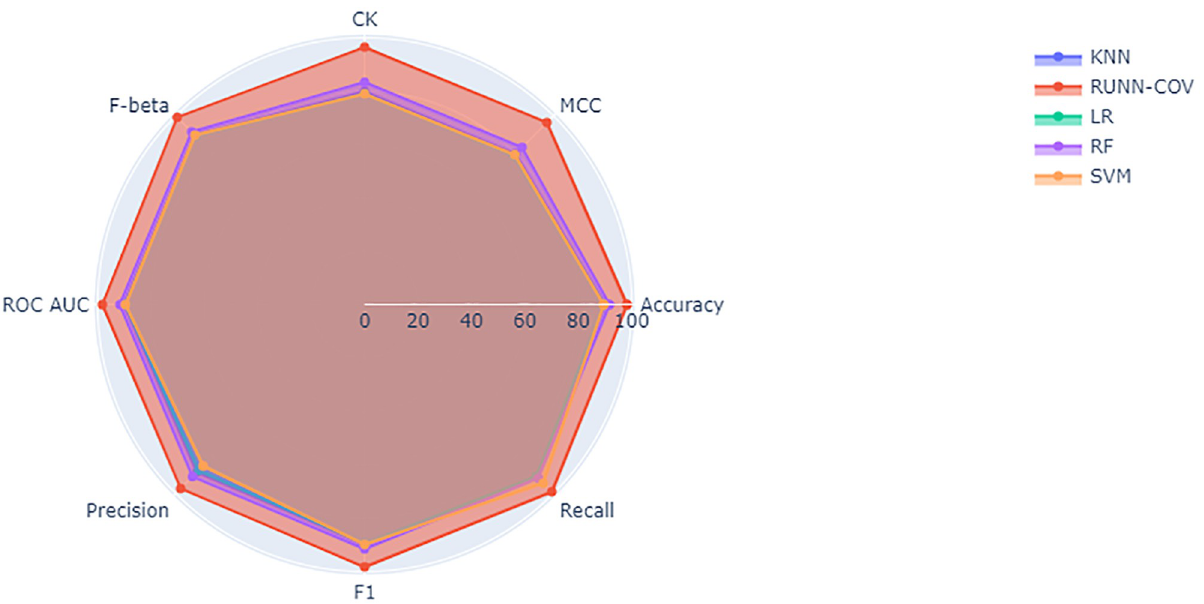
Fig 6. The radar chart illustrates the differences in performance metrics of KNN, RUNN-COV, logistic regression, random forest, and SVM algorithms. In this visual analysis, the different vertices show where each algorithm performs well and where each performs poorly.